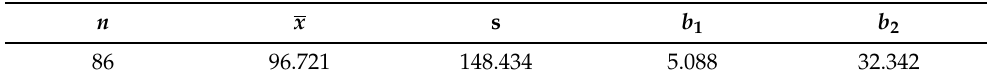
Table 3. Descriptive statistics for zinc data